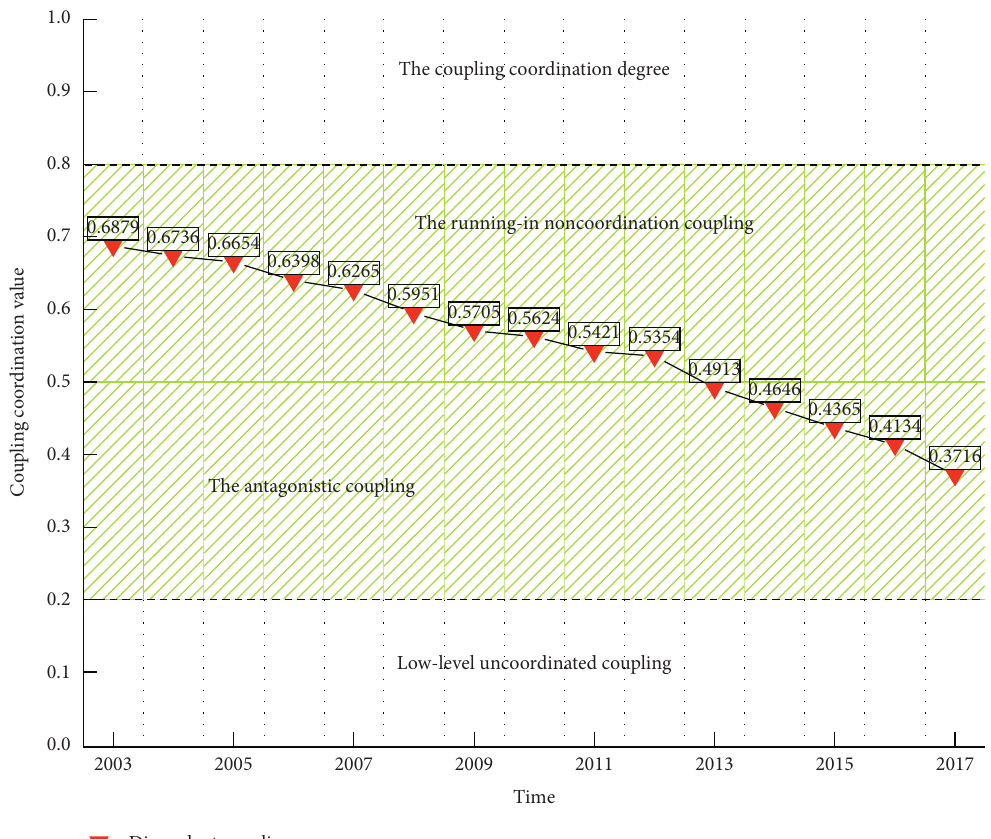
Figure 5: The noncoordination coupling evolution process of pro-poor tourism and eco-environment in Liupanshui city.